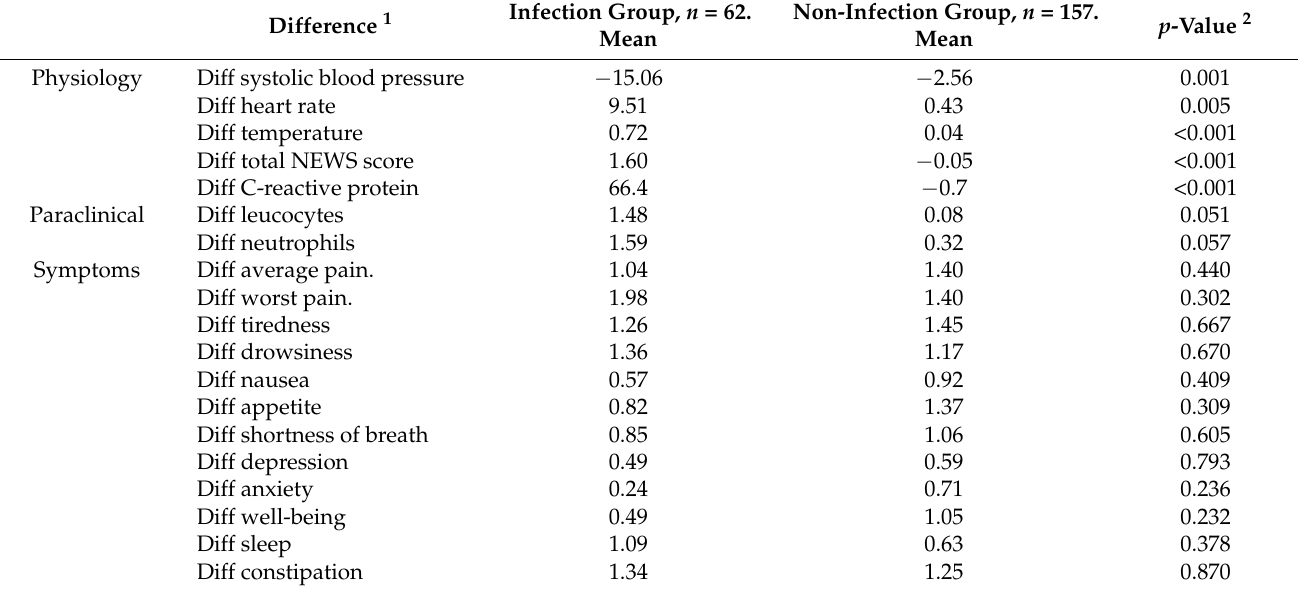
Table 4. Change from admission to discharge or 10